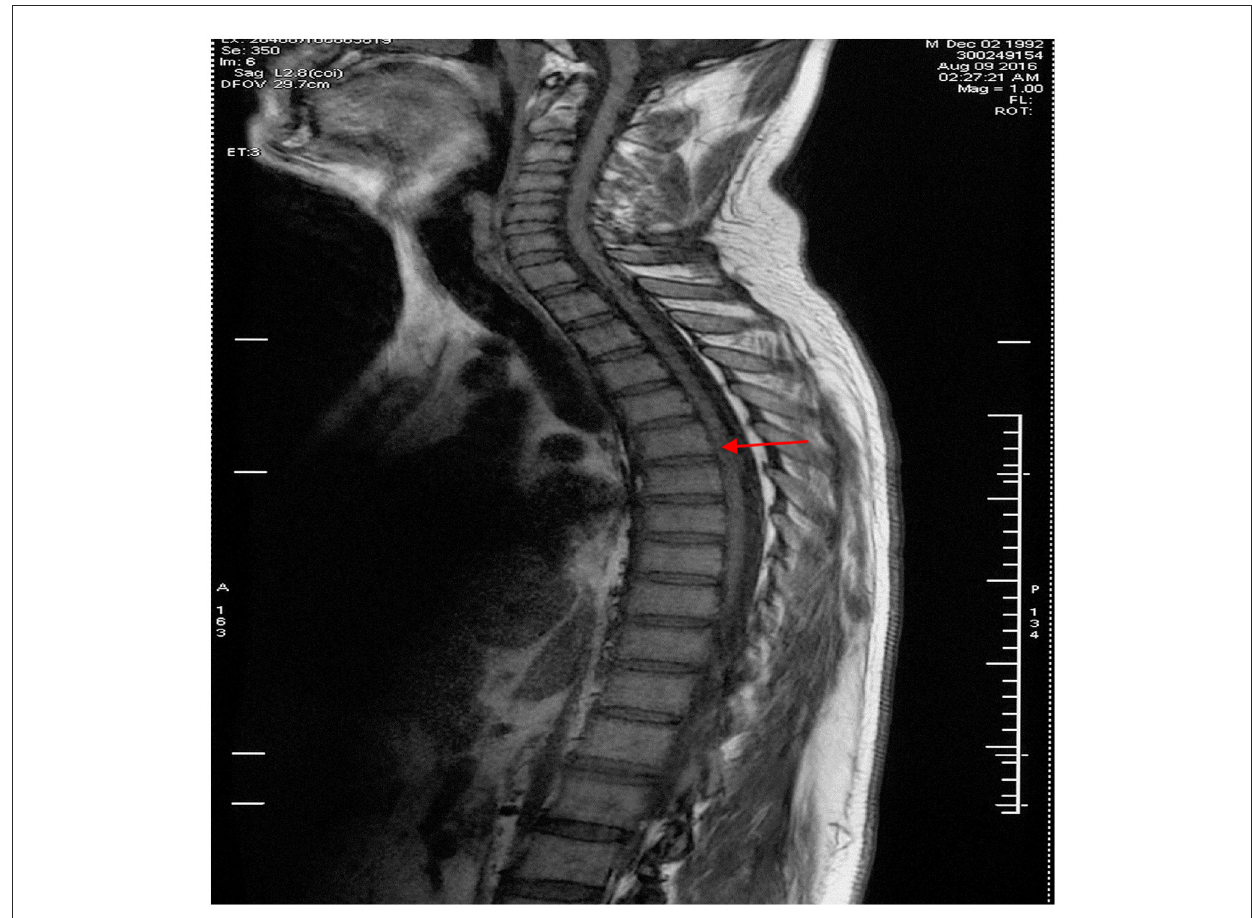
FIGURE2 Thoracic spinal MRI image in the proband. Thoracic spinal MRI revealed thinning of the thoracic spinal cord with volume loss but no abnormal signal in the cord on sagittal T1-weighted imaging, as indicated by the red